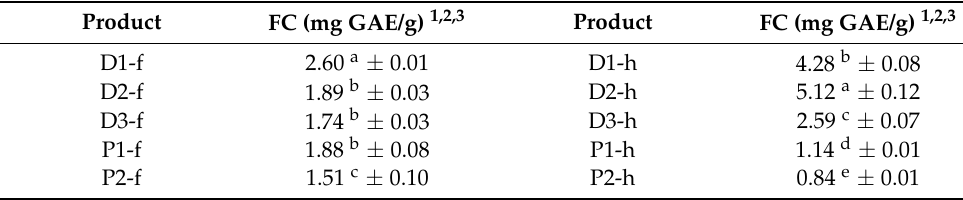
Table 6. Folin–Ciocalteau (FC) results for P. peruviana fruit and husk